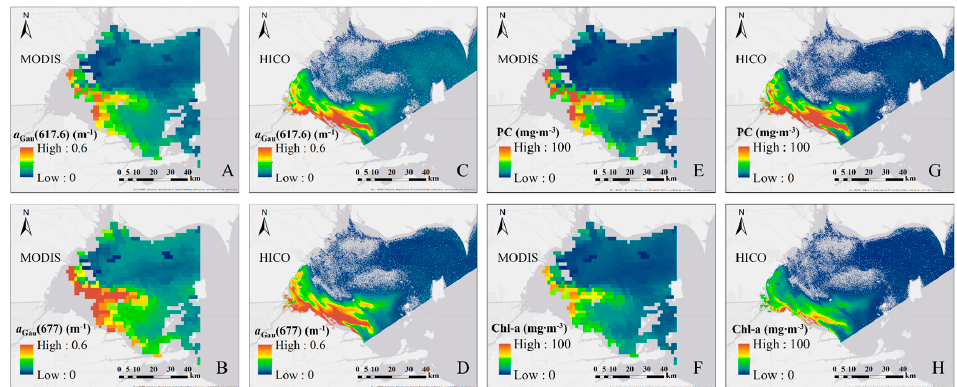
Figure 10. The spatial distributions of a Gau ( λ ) (m − 1 ) centered at 617.6 and 677 nm in western basin of Lake Erie from: MODIS (13 August 2014, 17:50:00 UTC) ( A , B ), and HICO (15 August 2014, 21:56:18 UTC) ( C , D ) remote sensing imagery; the distribution of phycocyanin (PC) and chlorophyll a concentrations (Chl-a) derived from MODIS ( E , F ) and HICO imageries ( G , H ).